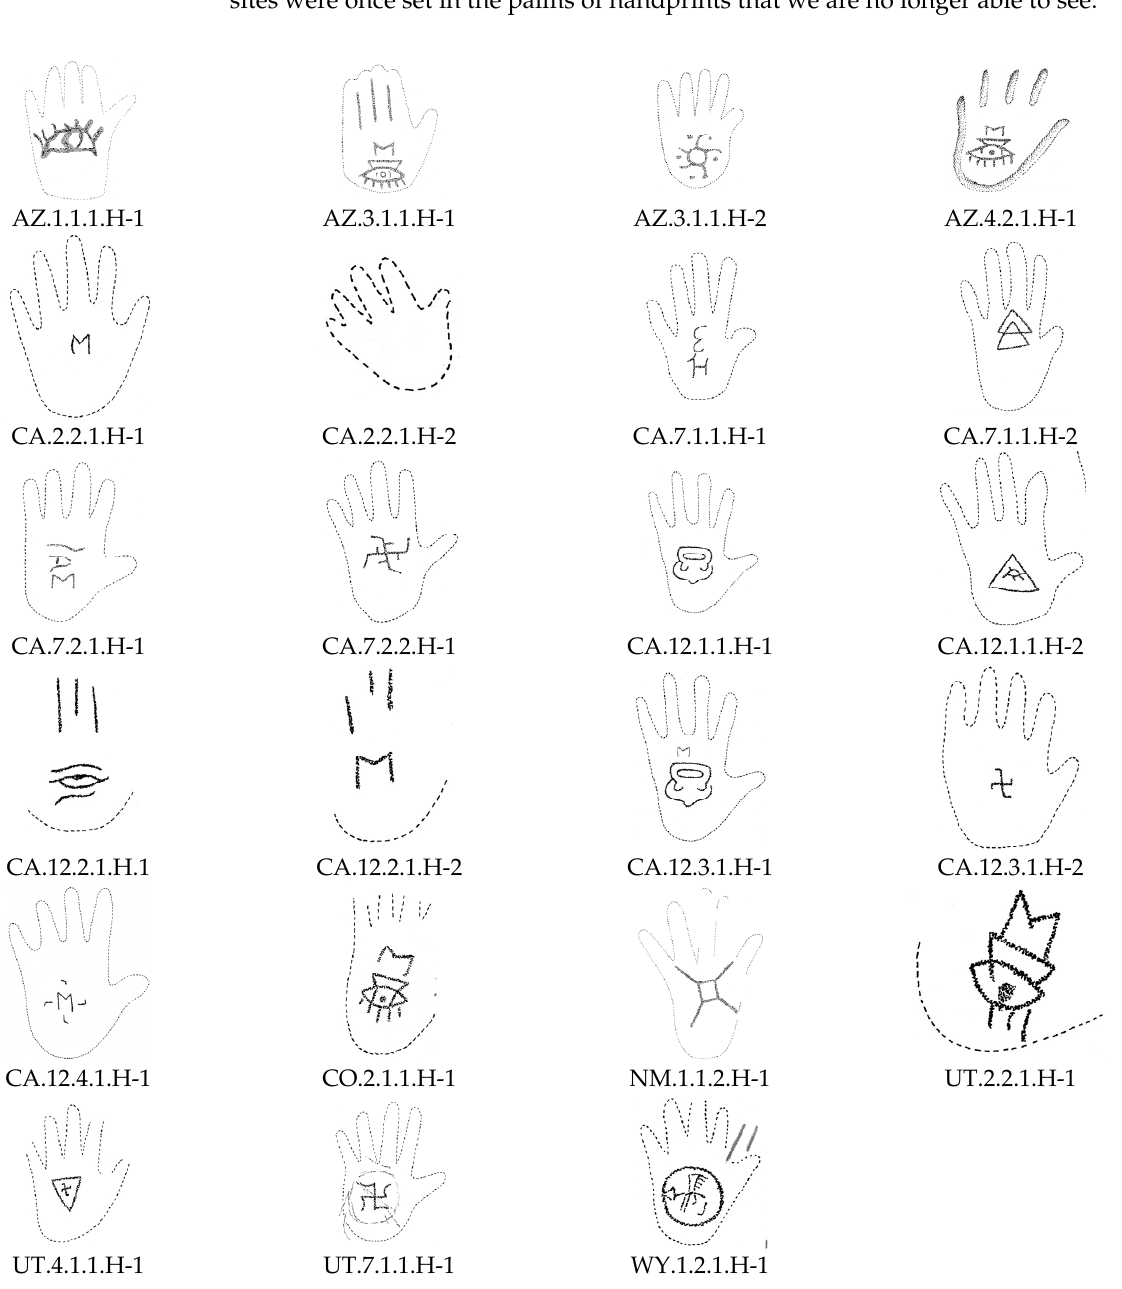
Figure 35. “Ghost” handprints (drawings by David